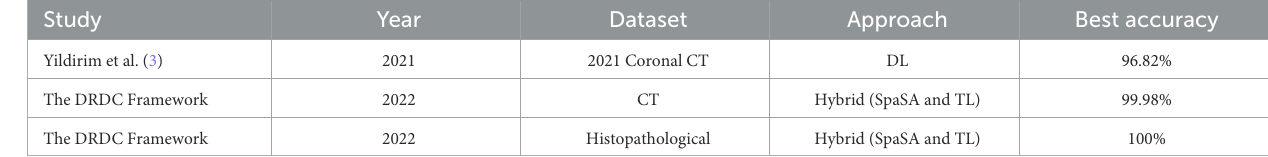
TABLE 17 A comparison of the proposed framework and related